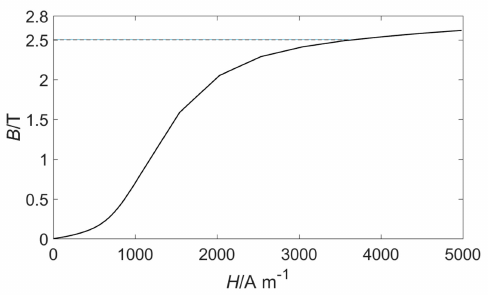
Figure 4. Magnetization curve of the 24 mm wire